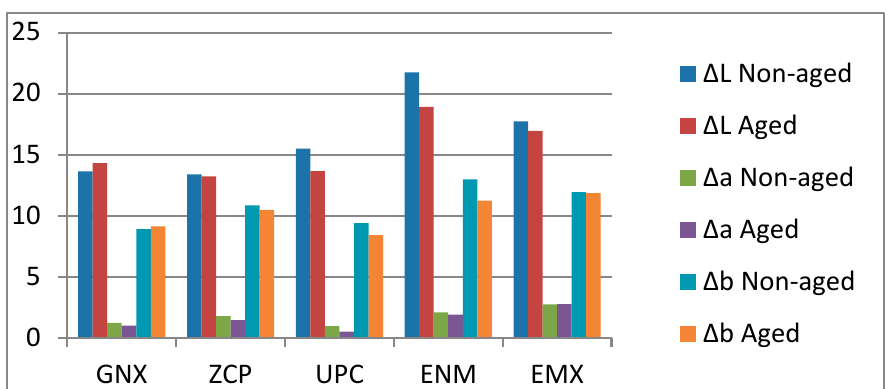
Figure 3. CIE Δ L Δ a Δ b values on white and black backgrounds for the non-aged and aged Figure 3. CIE ∆ L ∆ a ∆ b values on white and black backgrounds for the non-aged and aged groups. groups. The shade difference ∆ E mean values for the non-aged and aged groups on white, black, and white/black backgrounds are shown in Table 4 and represented by a bar graph in Figure 4. ENM had the highest shade difference of 2.12, whereas ZCP had the lowest of Table 4. Descriptive Δ E values of the non-aged and aged groups on white and/or black back- 0.95; with a range of only 1.17. grounds. Table 4. Descriptive ∆ E values of the non-aged and aged groups on white and/or black backgrounds. Mean of ∆ E at Mean of ∆ E at Mean of ∆ E at White and Material White Background Black Background Black Background